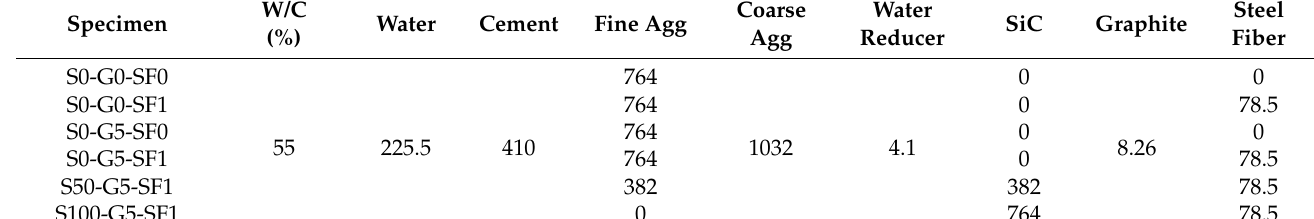
Table 5. Mixing properties of the specimens (unit: kg/m 3 ).